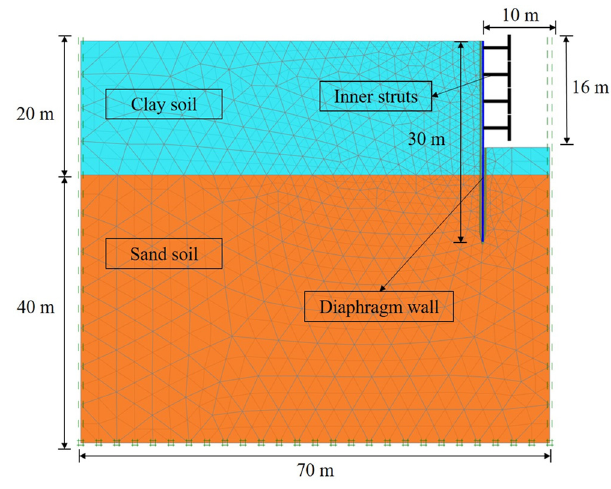
Figure 1. Finite element model for deterministic analysis. Table 1. Construction steps and parameters of retaining structural system.